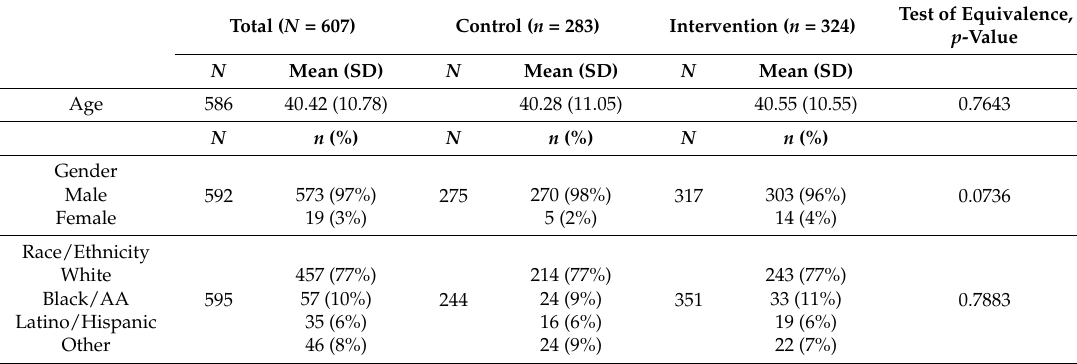
Table 1. Distribution of demographic characteristics at baseline ( N =